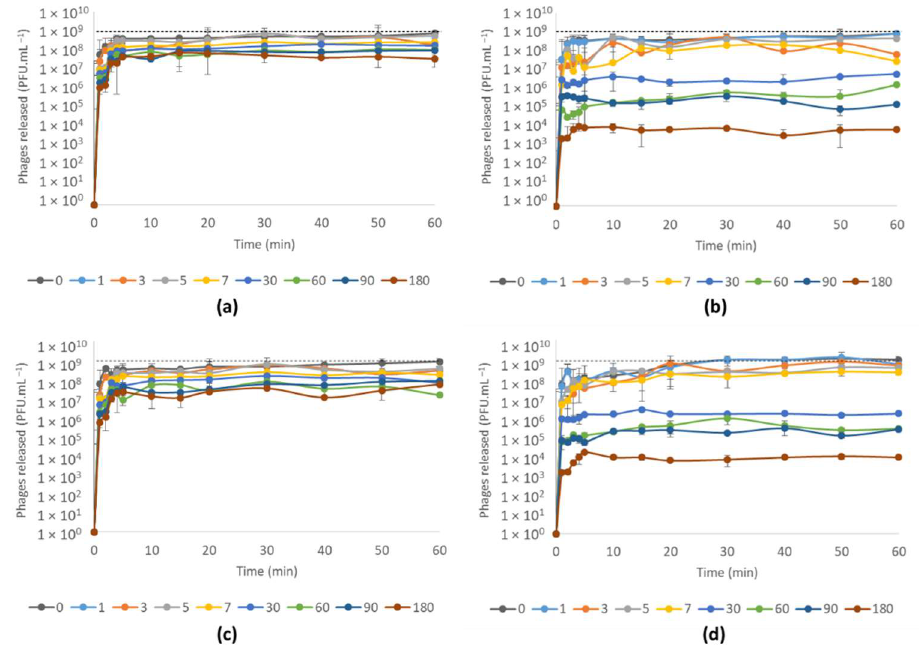
Figure 6. Release of phage vB_PaeM-SMS2s9 from PVA MNs after storage at 4 °C and room temperature (RT) for different periods up to 180 days. ( a ) SMS29 release from BA MN stored at 4 °C; ( b ) SMS29 release from BA MNs stored at RT; ( c ) SMS29 release from INL MNs stored at 4 °C; ( d ) SMS29 release from INL MNs stored at RT. The dashed lines correspond to the concentration of phages added to the fabricated MNs.